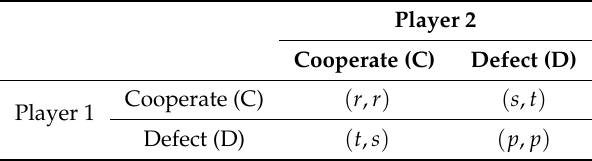
Table 1. Symbolic payoff matrix for the prisoner’s dilemma game.